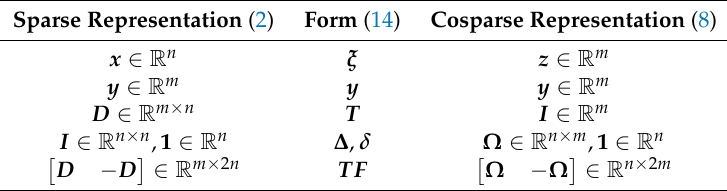
Table 1. Equivalences of the sparse and cosparse representations w.r.t. form (14). Sparse Representation (2) Form (14) Cosparse Representation (8) R x ∈